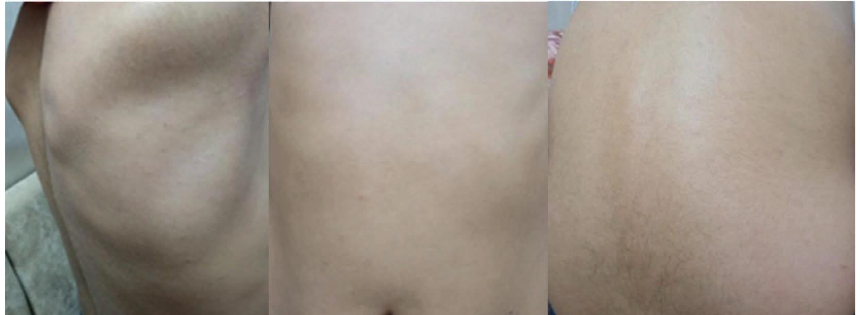
Figure 5: Signifcant improvement of the patient’s symptoms after phototherapy.